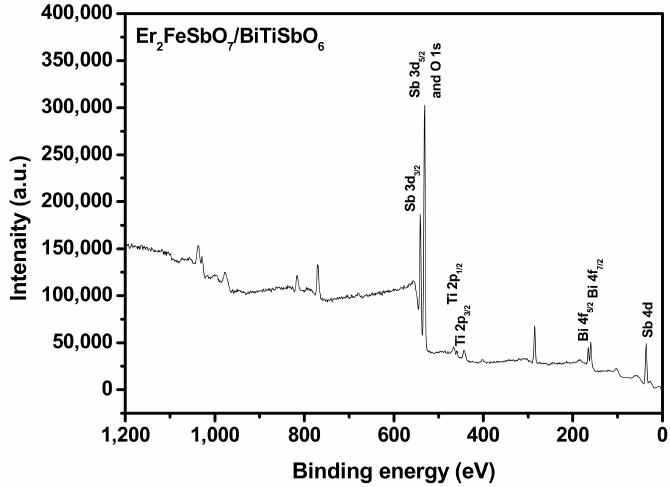
Figure 5. XPS survey spectrum of the EBHP before the